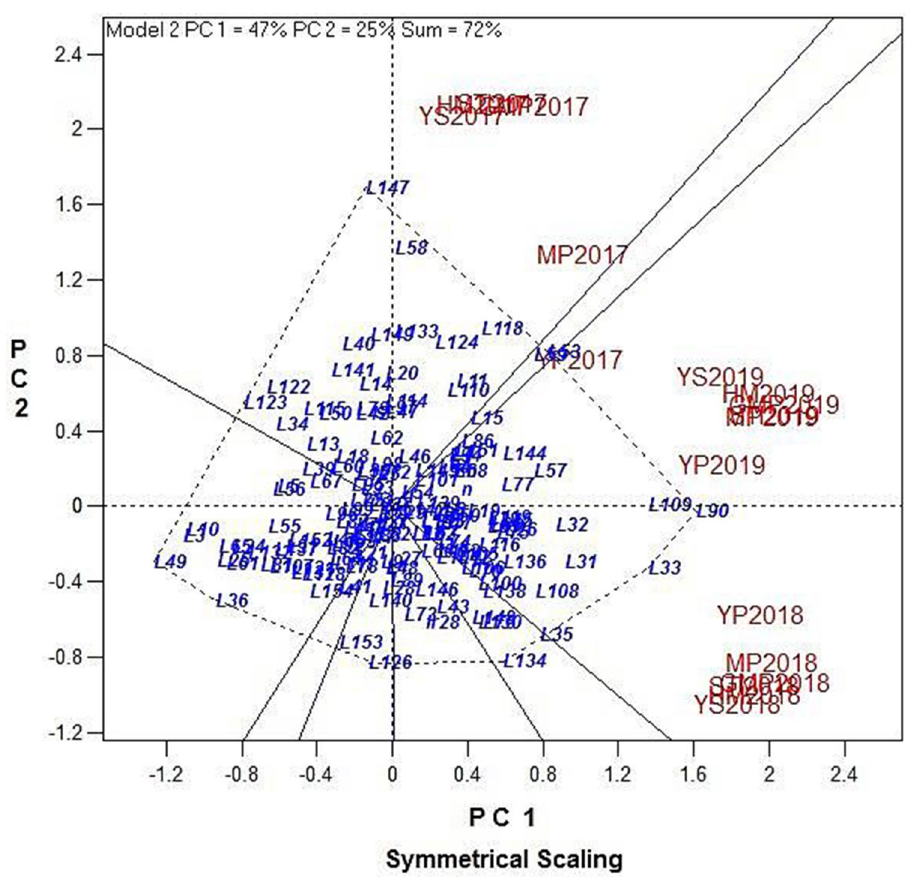
Figure 5. Polygon view of the rice RILs GT-biplot, showing which line had the highest values for which drought indices during 3